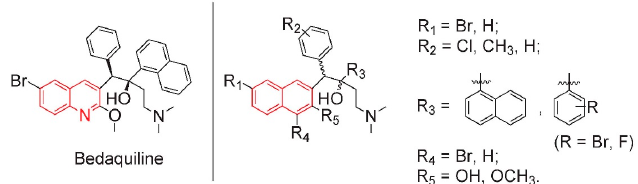
Figure 1. Structure of bedaquiline and our designed analogues of the TARB skeleton.